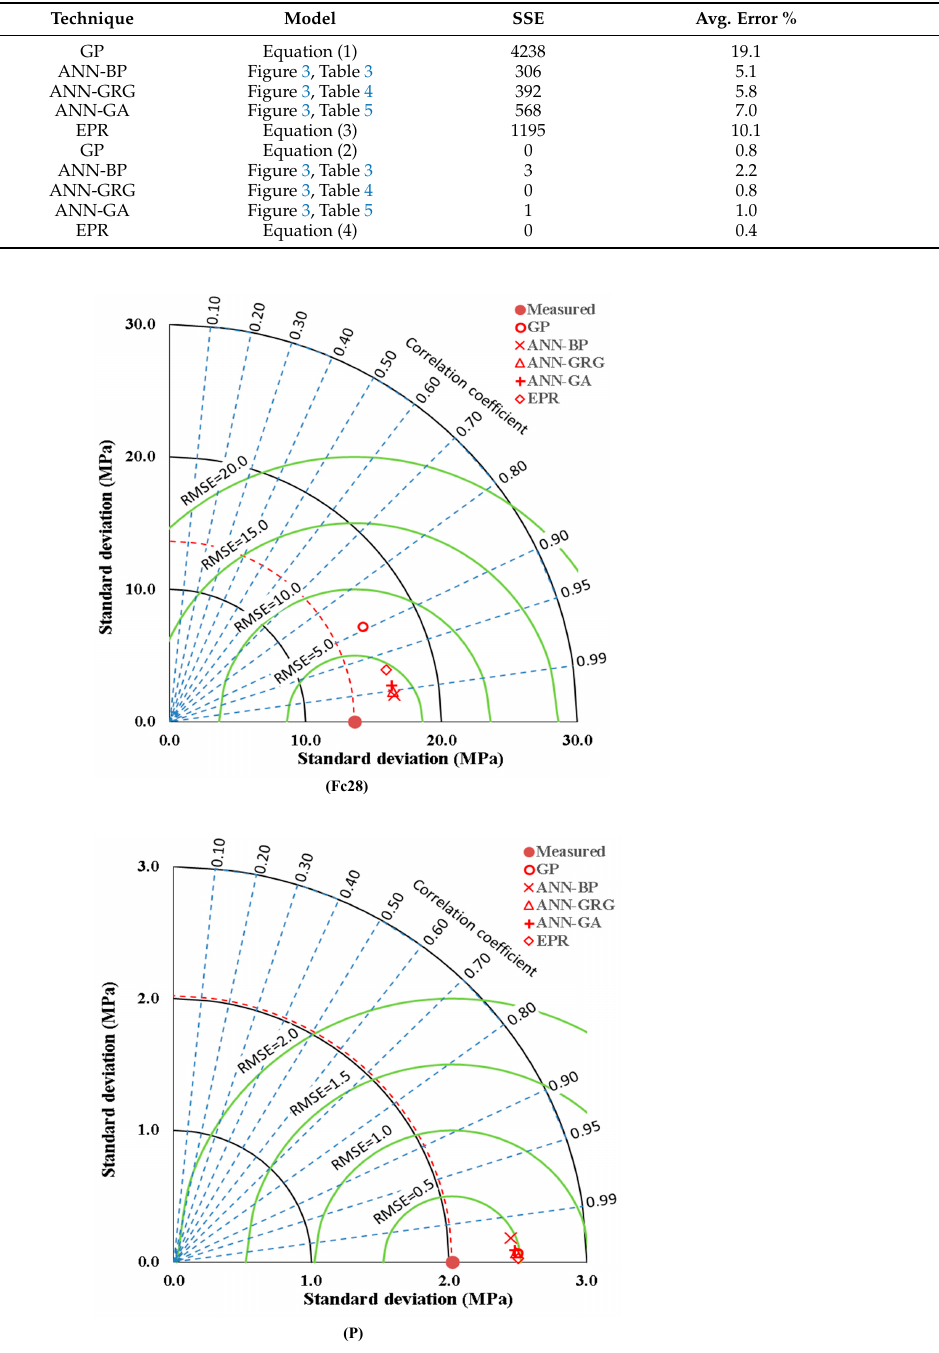
Figure 5. Comparison between developed models using the Taylor diagram for the compressive strength (Fc28) and the life cycle assessment impact point (P).